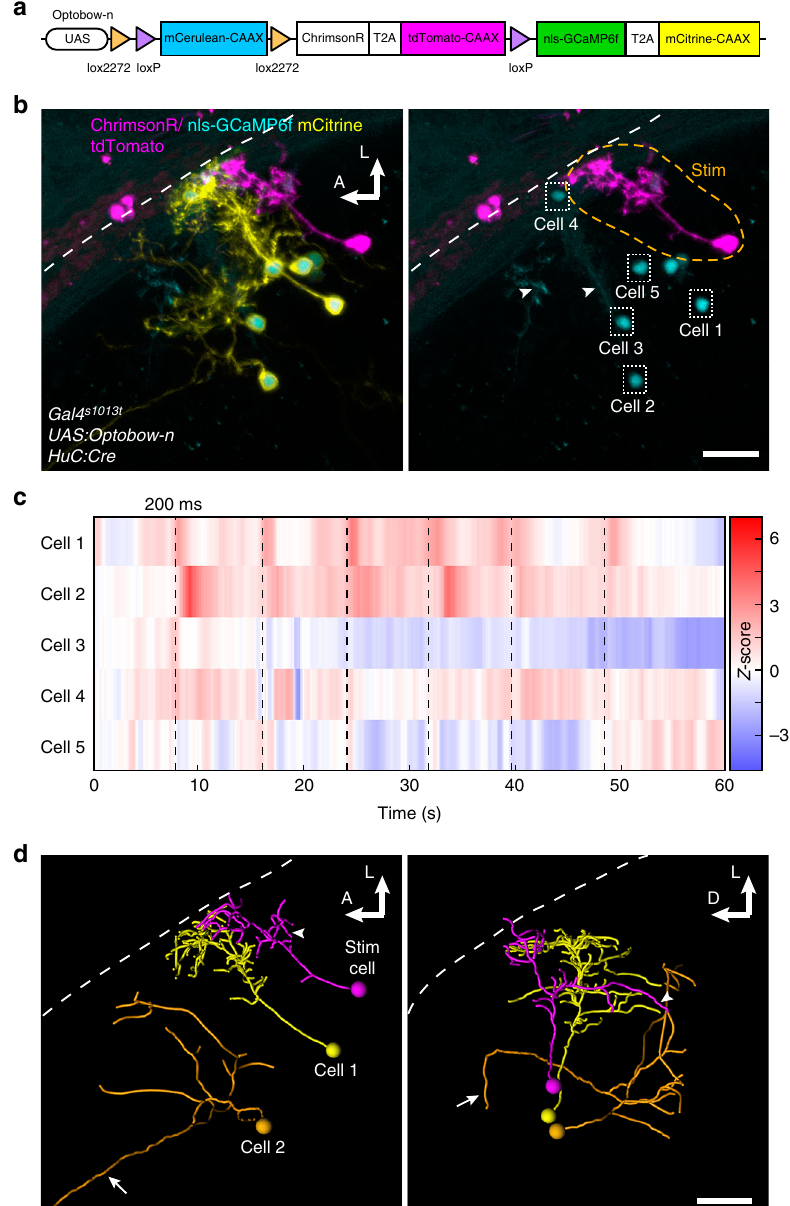
Fig. 2 Simultaneous connectivity mapping and morphological analysis with Optobow-n. a Schematic of the Optobow-n construct. b Tectal-speci fi c expression of Optobow-n. A single ChrimsonR-expressing cell ( magenta ) is surrounded by seven nls-GCaMP6f-expressing cells, membrane-labeled by mCitrine ( yellow ). Localization of GCaMP6f ( cyan ) appears completely restricted to the nucleus. White dashed line indicates skin. Orange dashed line in two- channel merge ( right image) marks photostimulated region. Dotted rectangles show regions of calcium imaging during photostimulation. Arrowheads show mCerulean signals in non-recombined cells. Scale bar, 20 µ m. c Calcium transients ( Z -scores) acquired at 10 fps from the regions annotated in b . Photostimulation events of 200 ms are marked by dashed lines . While calcium activity of cell#1 is tightly coupled to the photostimulation, activity of cell#2 appears slightly delayed. No signi fi cant calcium responses were detectable in other neighbouring cells (#3 – 5). d Three-dimensional tracings of the photostimulated cell ( magenta ) and the two responding cells. Dorsal view is shown on the left and transverse view on the right . The stimulated cell is a bistrati fi ed projection neuron with a descending axon ( arrowhead ). Cell#1 is a bistrati fi ed periventricular interneuron and cell#2 is a non-strati fi ed projection neuron, which sends an axon to the intertectal commissure ( arrows ). Scale bar , 20 µ (RGC) axons, other afferents, or the axons of tectal interneur- ons 26 . The axons of PVNs extend from the same stem neurite as the dendrites and either synapse on other tectal neurons or leave the tectum to form connections with areas in the diencephalon, midbrain or hindbrain.